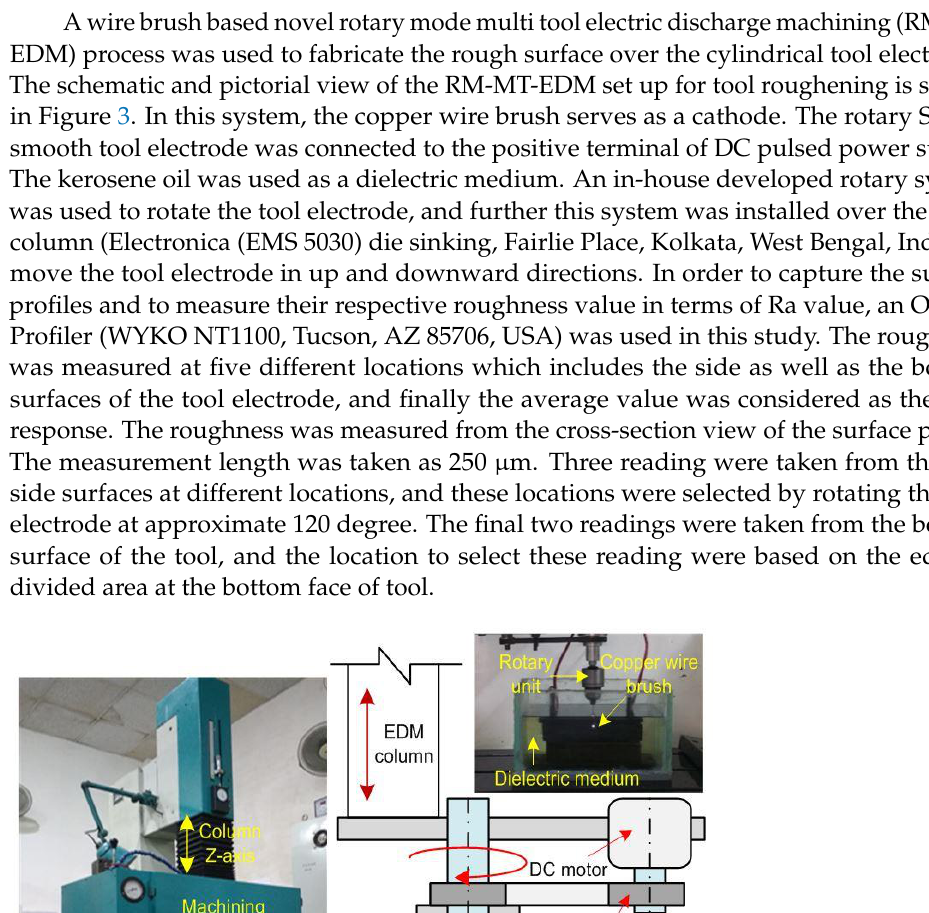
Figure 2. Schematic view of ECSM machine.